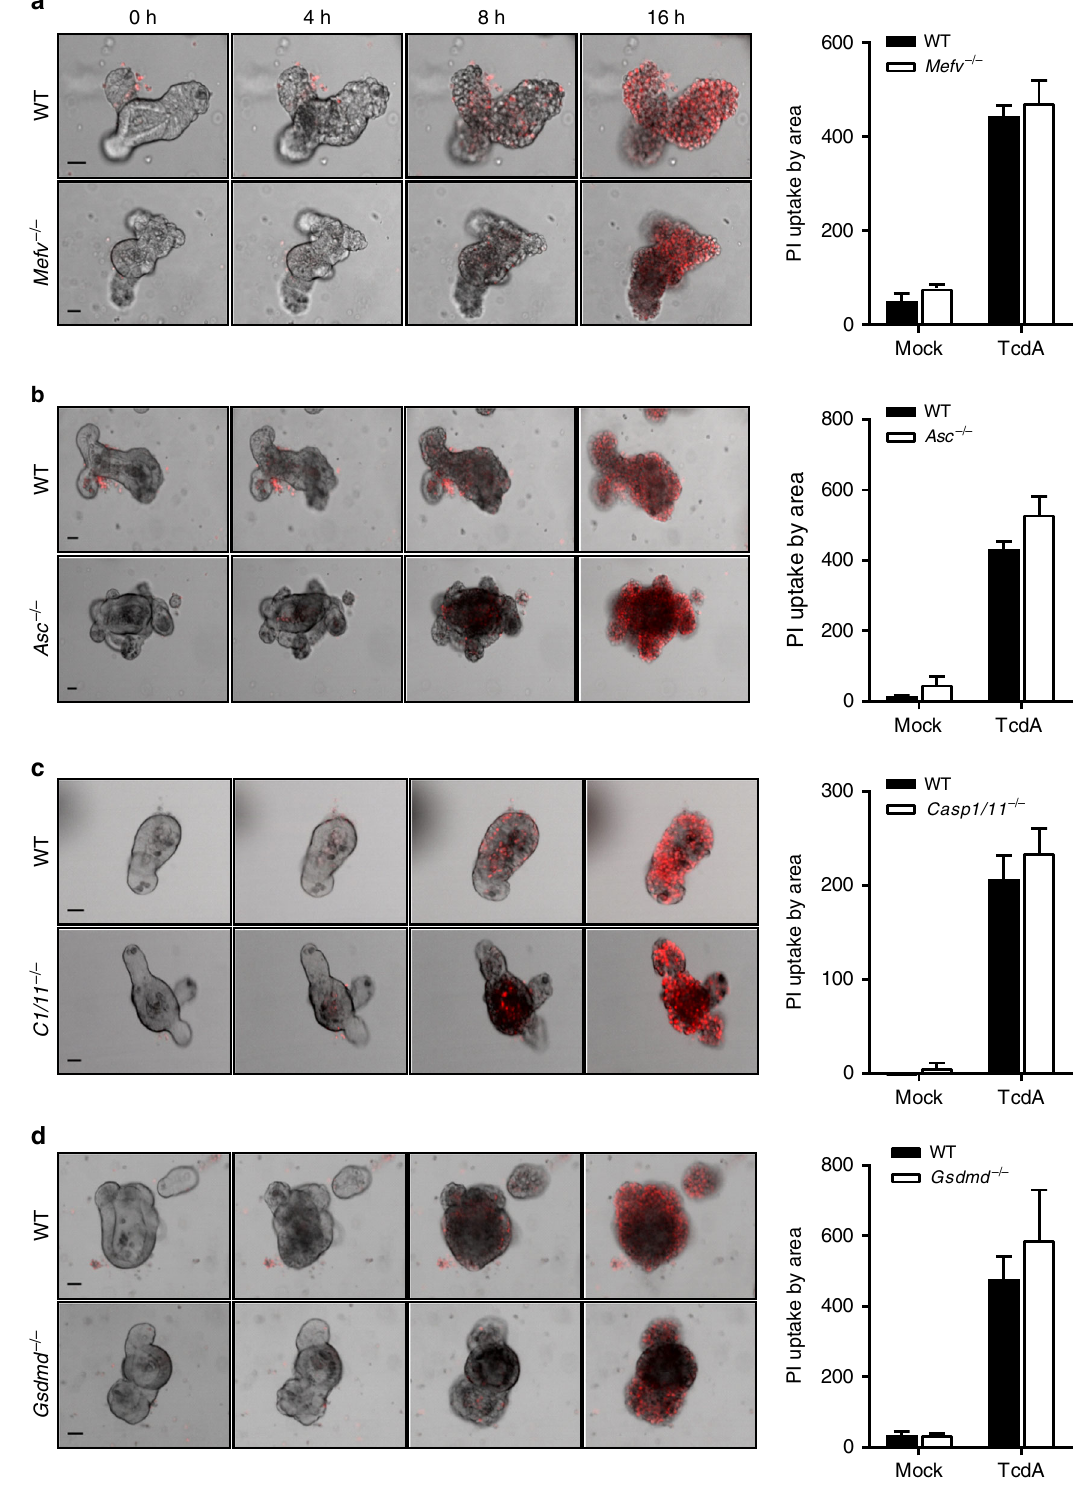
Fig. 1 In fl ammasome activation and pyroptosis are dispensable for C. dif fi cile TcdA-induced IEC cytotoxicity. a – d Primary intestinal organoids from wild- type (WT) and a Mefv − / − , b Asc − / − , c Casp1/11 − / − or d Gsdmd − / − mice were stimulated with TcdA and PI incorporation analyzed by live-imaging for 16 h. Graphs correspond to PI quanti fi cation plotted by organoid area. Scale bars: 30 µ m. The data are representative of at least 3 independent